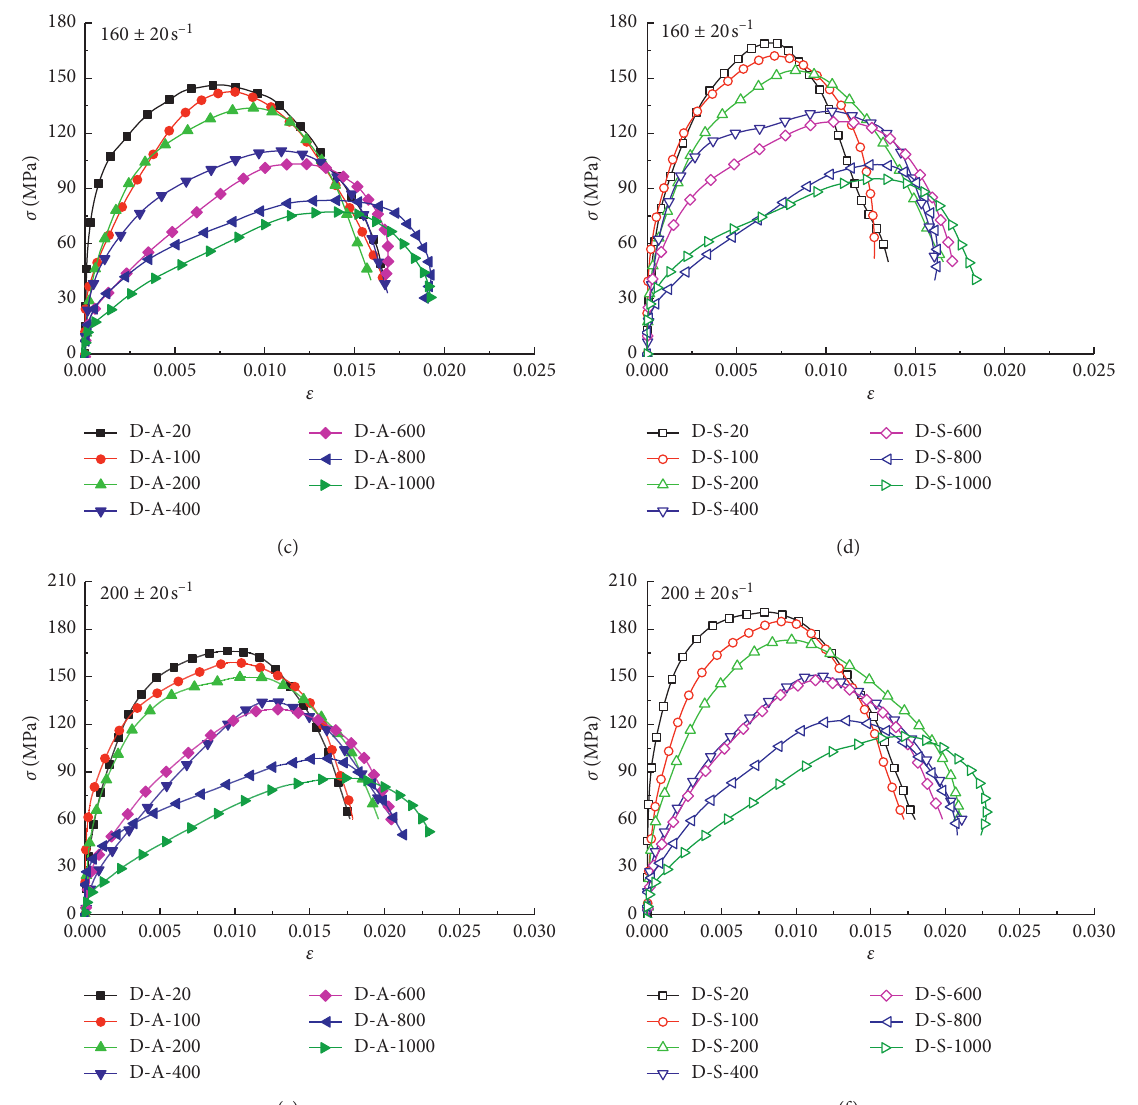
Figure 6: Dynamic uniaxial compression stress-strain curves of argillaceous sandstone after high temperature. (a) Air-dried state (120 ± 20s − 1 ). (b) Saturation state (120 ± 20s − 1 ). (c) Air-dried state (160 ± 20s − 1 ). (d) Saturation state (160 ± 20s − 1 ). (e) Air-dried state (200 ± 20s − 1 ). (f) Saturation state (200 ± 20s − 1